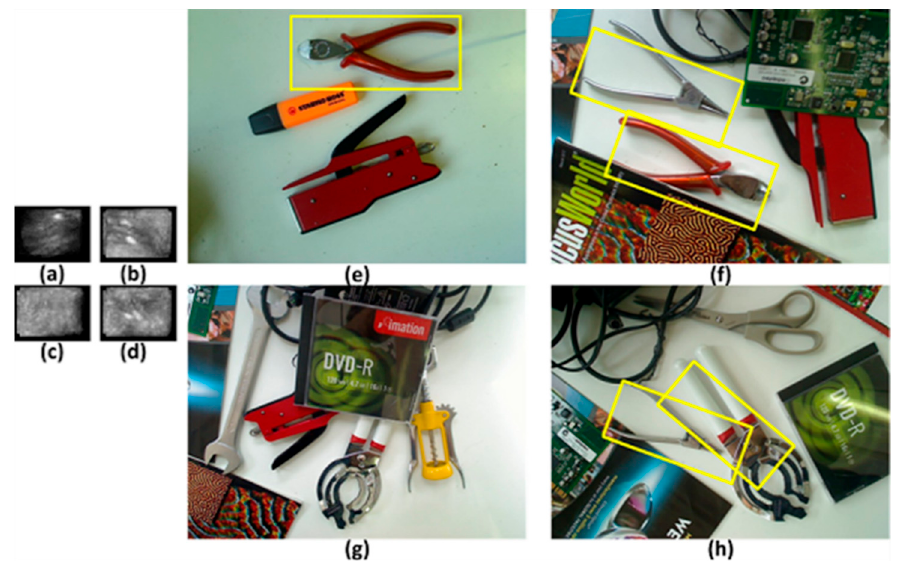
Figure 4. Possible object locations. ( a – d ) The similarity score of CMI. ( e ) There is only one possible object location; ( f ) There are two possible object locations, and one of them is the positive; ( g ) There are no possible object locations; ( h ) Unfortunately, there are two negative possible object locations, but they can be eliminated in the second stage.